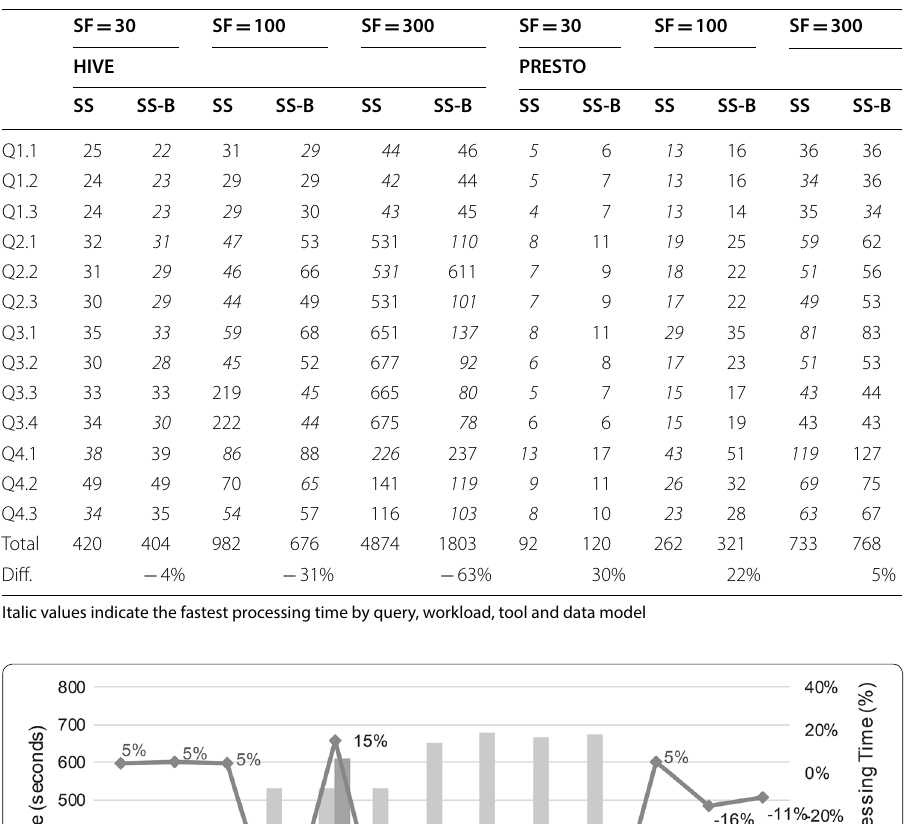
Table 6 SSB execution times (in seconds): bucketing by “Suppkey”